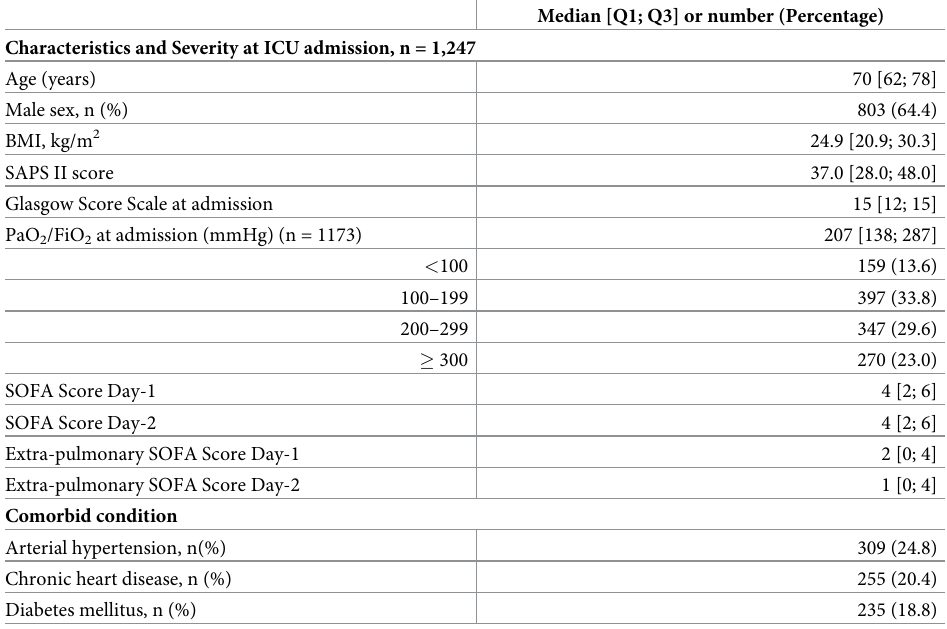
Table 1. Baseline characteristics of the population at admission to ICUs for severe